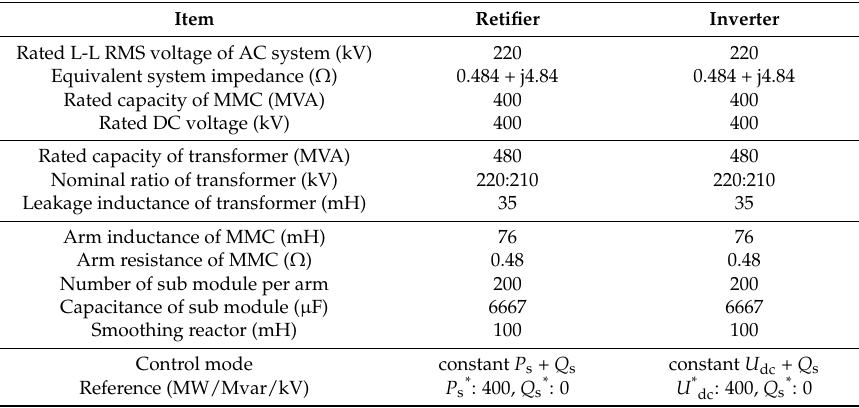
Table A1. System Parameters of the MMC-HVDC